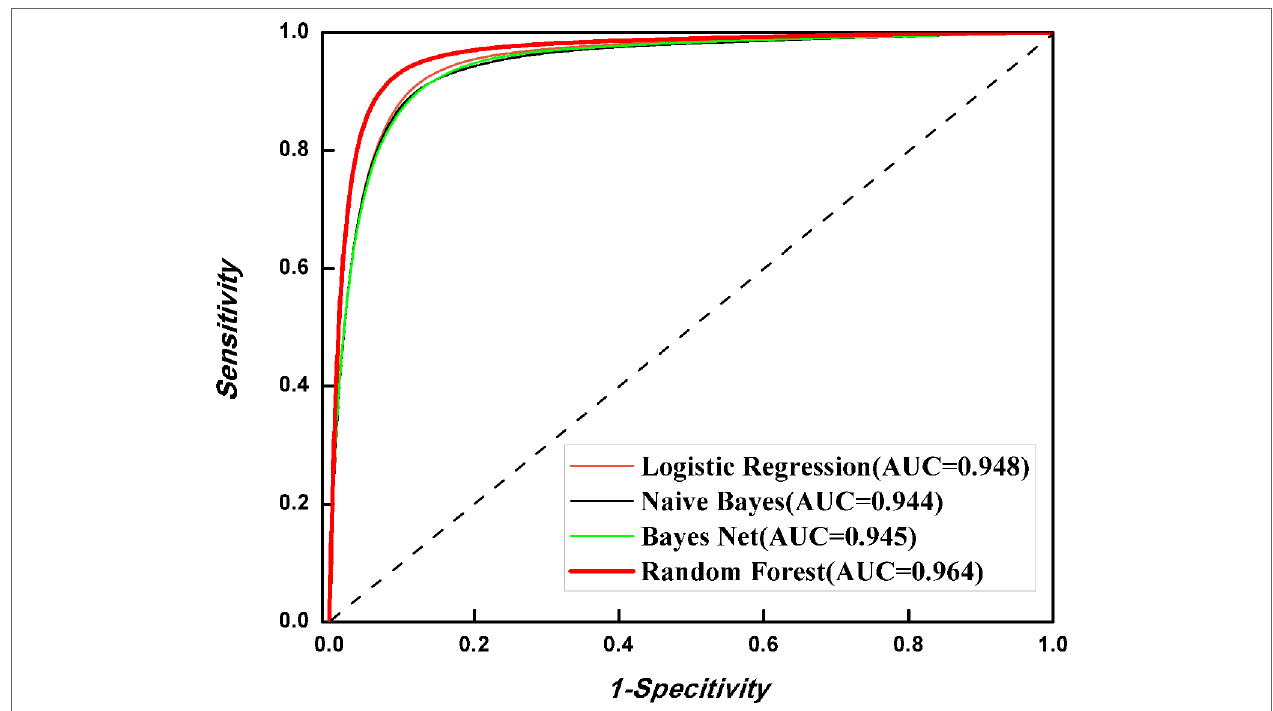
FIGURE 5 | Performance evaluation of different algorithms.